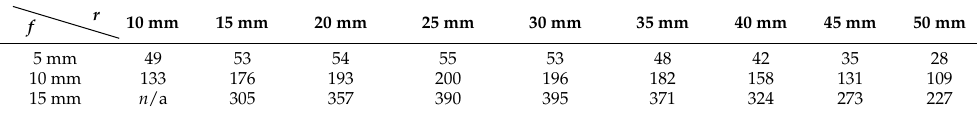
Table 1. Simulated irradiation power on 50 × 50 mm 2 area solar cell